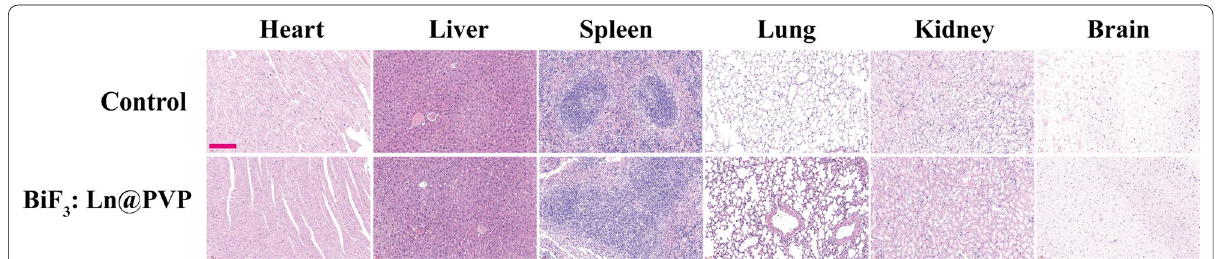
Fig. 5 H&E staining images of major organs before and after BiF 3 : Ln@PVP NPs administration (scale bar 200